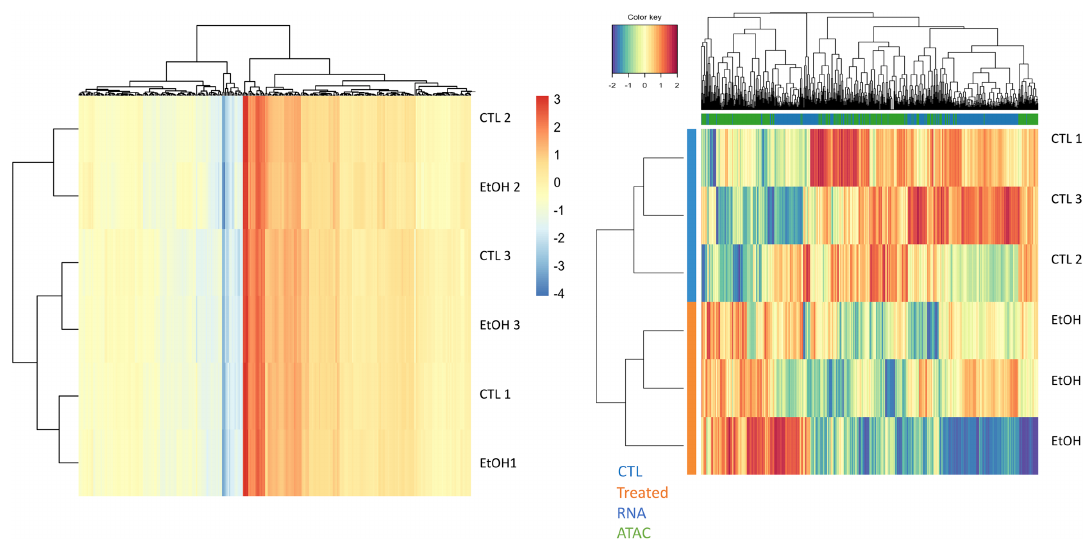
Fig 3. Clustering analysis of differentially expressed genes and differentially accessible regions. (A) Hierarchical clustering of normalized counts of differentially expressed genes led to partial clustering of treatment response. (B) Hierarchical clustering of 114 normalized gene counts and differentially accessible peaks for genes found to be significant across both omic layers led to complete separation of samples based upon treatment response. Increasing values indicated increased gene expression or chromatin accessibility in controls relative to ethanol treated